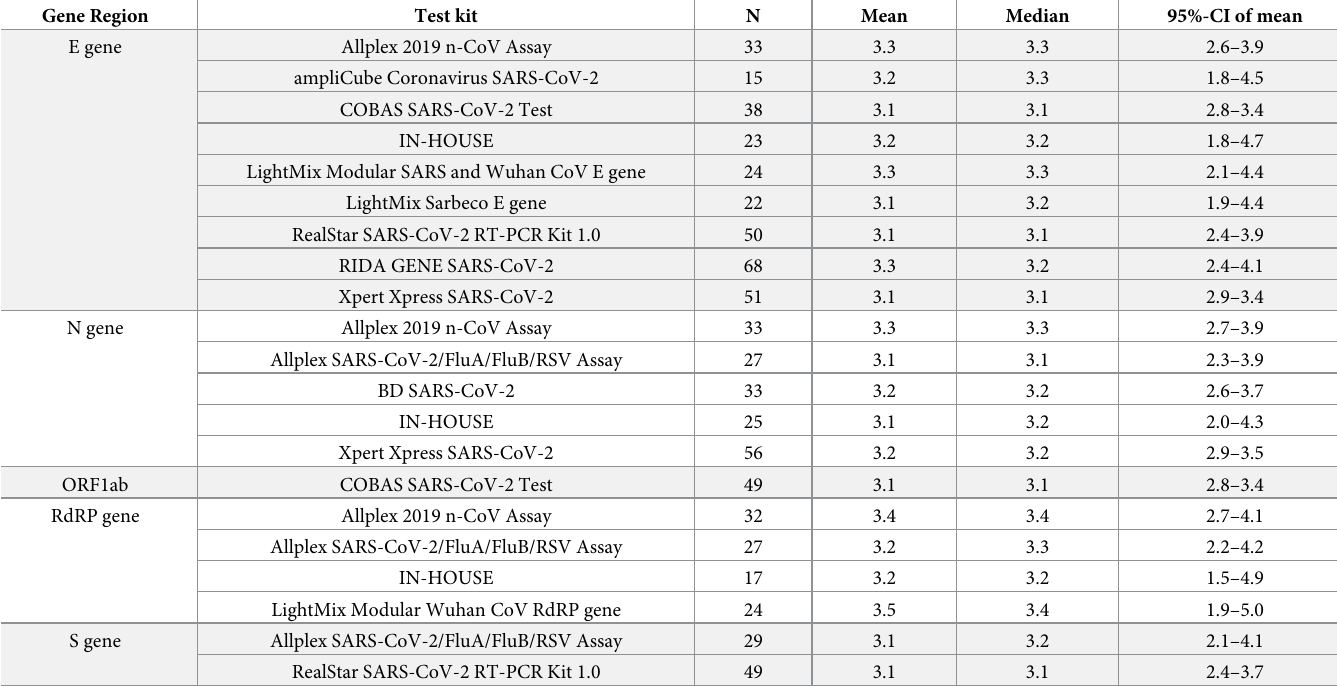
Table 5. Statistical analysis of Ct value differences per gene region and test system for RM 1 and RM 2: Mean, median and 95%-CI of mean. Gene